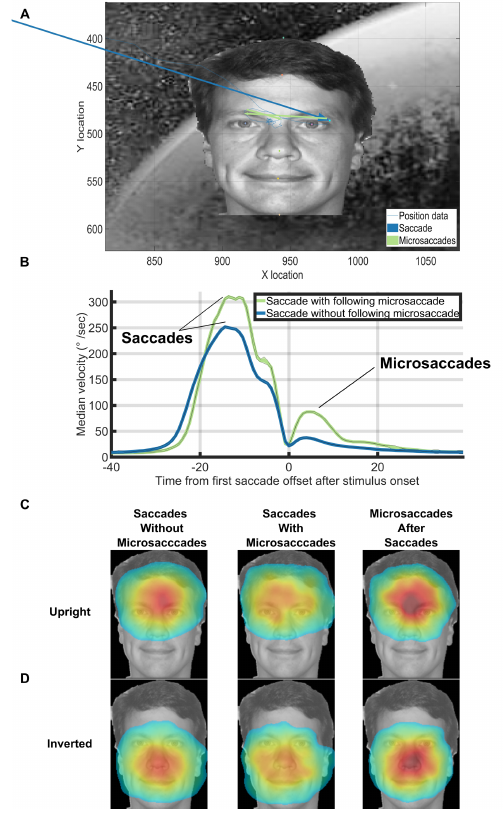
Figure 5. (A) An example with 2 microsaccades directly after a correct saccade in Experiment 3. (B) Median velocity on cor- rect upright background trials at each timepoint. Trials were aligned on the offset time of the first saccade after trial onset. Note the microsaccades that sometimes occurred almost imme- diately after the preceding saccade (green line after 0ms). (C, D) Saccades without microsaccades and saccades with mi- crosaccades shared the same facial landmark target frequencies within correct background trials for both upright and inverted face conditions. Saccades with following microsaccades were qualitatively less accurate than saccades without following microsaccades. However, the microsaccades that occurred after saccades shared the same landing endpoint distributions as saccades without microsaccades. The heatmaps for the inverted faces were flipped vertically for ease of presentation. To make the heatmaps, the 7 face landmark locations for each trial were mapped to the 7 face landmark locations of the template face using the Procrustes algorithm. We then mapped the first sac- cade after trial onset or the subsequent microsaccades into the template face’s space. Finally, we fit a normalized 2D gaussian to the raw saccade/microsaccade endpoint data using the heatmap function in PyGaze. The colormaps for each condition share the same minimum and maximum values and correspond to the jet colormap which goes from blue (low frequency), to yellow/green (medium frequency), to red (high frequency). Source image in Figure 5ACD are from one of the authors of this paper.